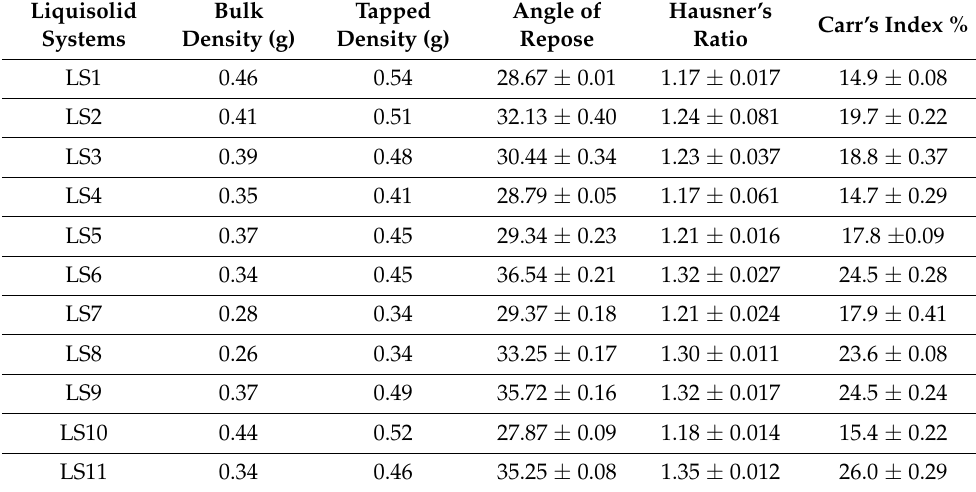
Table 3. Angle of repose, Carr’s index, Hausner’s ratio of all liquisolid